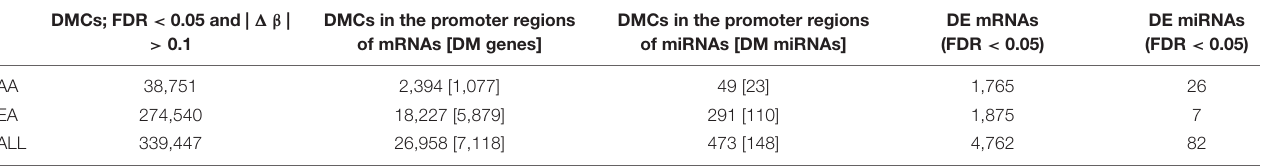
TABLE 2 | Significant molecules identified within each omic dataset